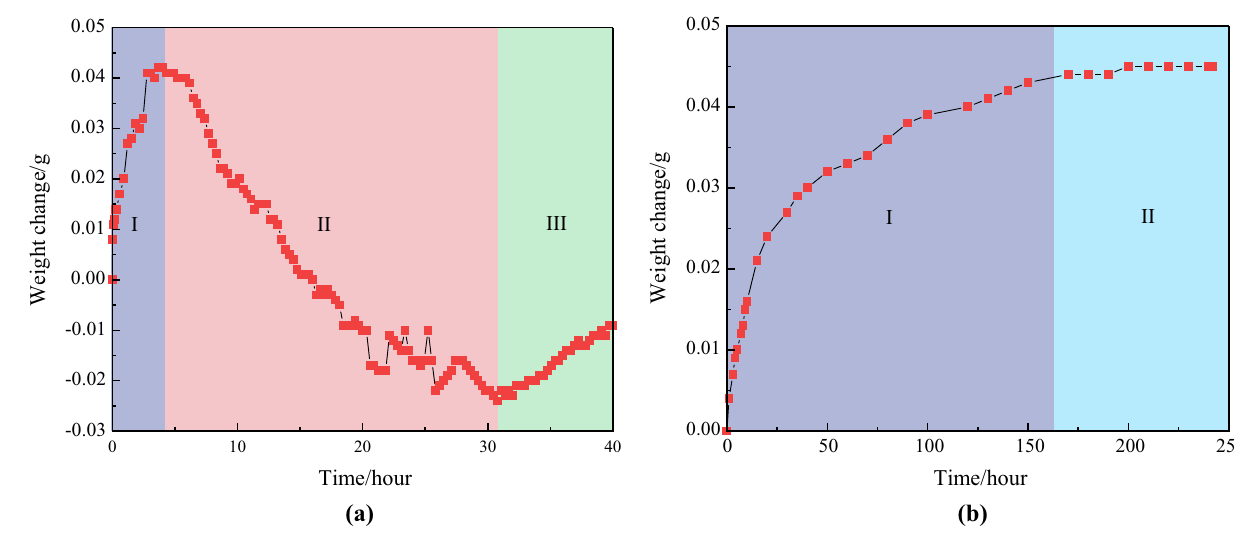
Fig. 7 SI of high-salinity brine (24 wt% KCl). a S